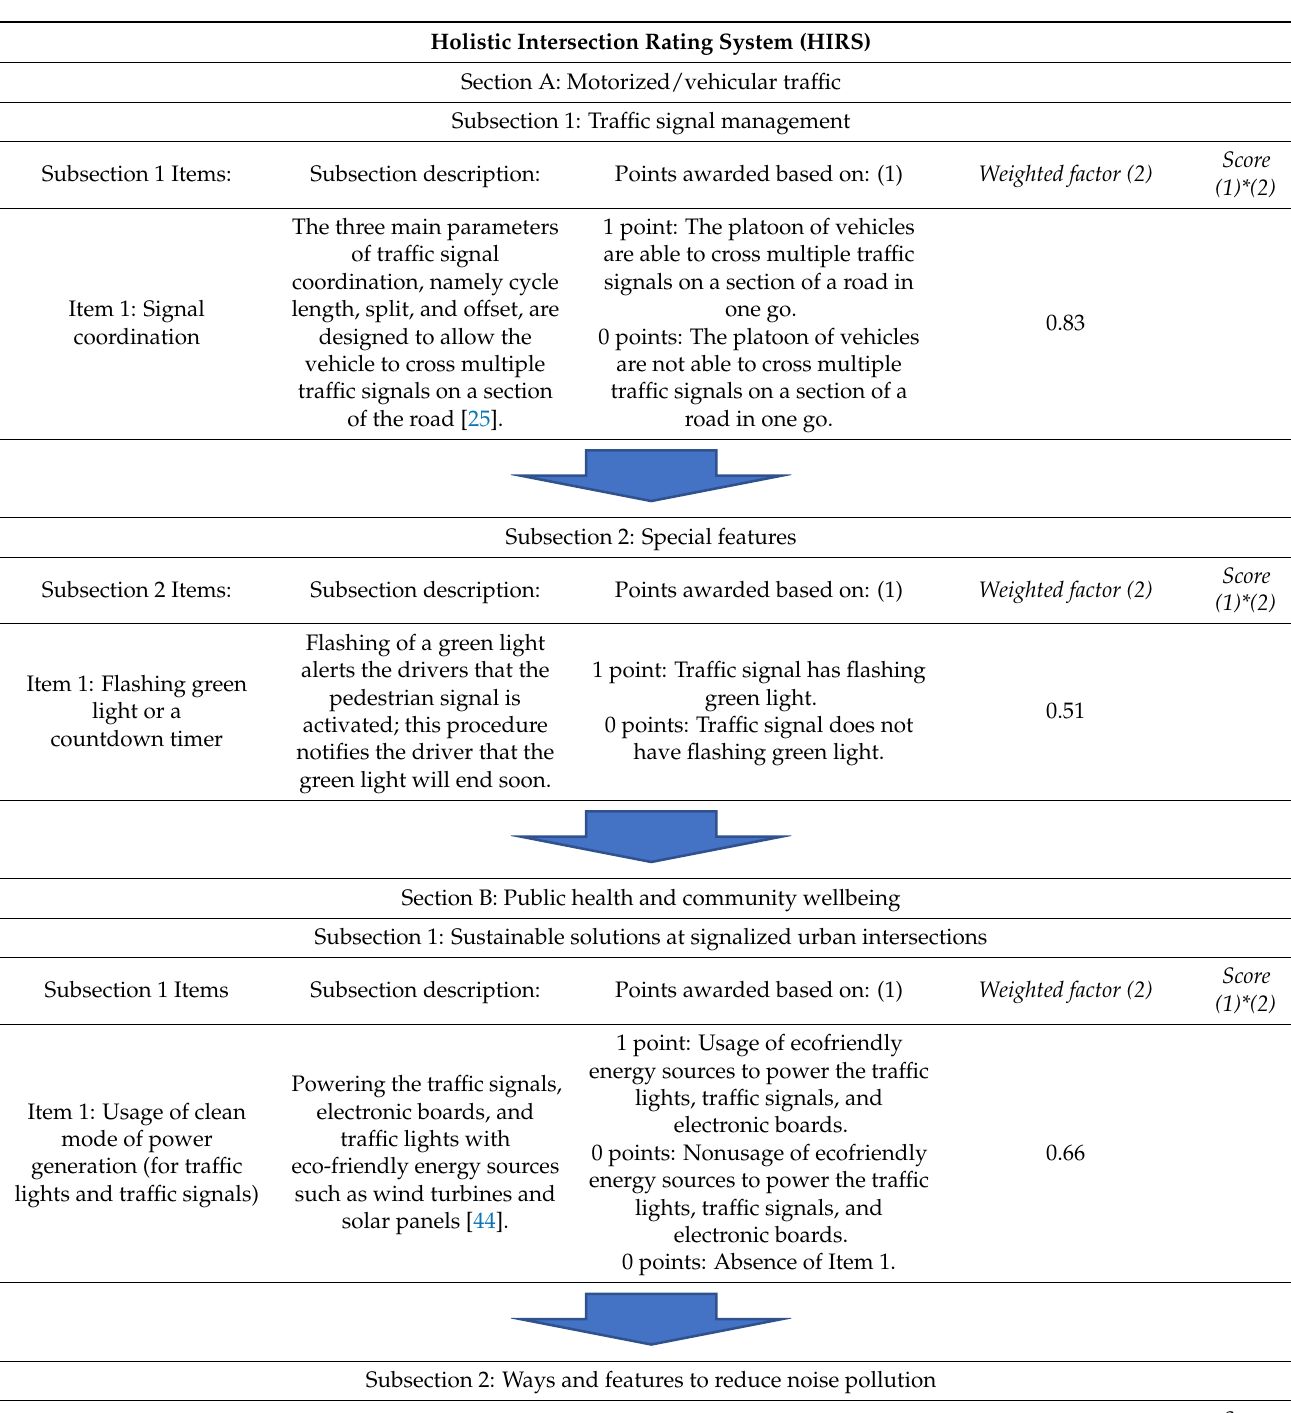
Table A1. A Partial Overview of HIRS’s